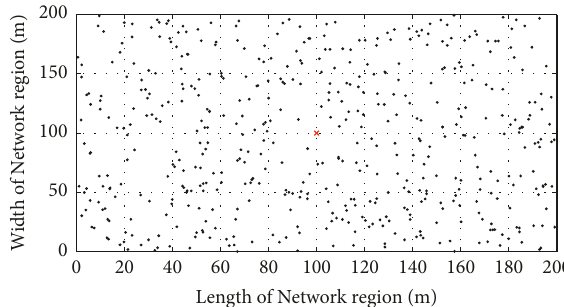
Figure 7: Random deployment of a wireless sensor network with 500 nodes.